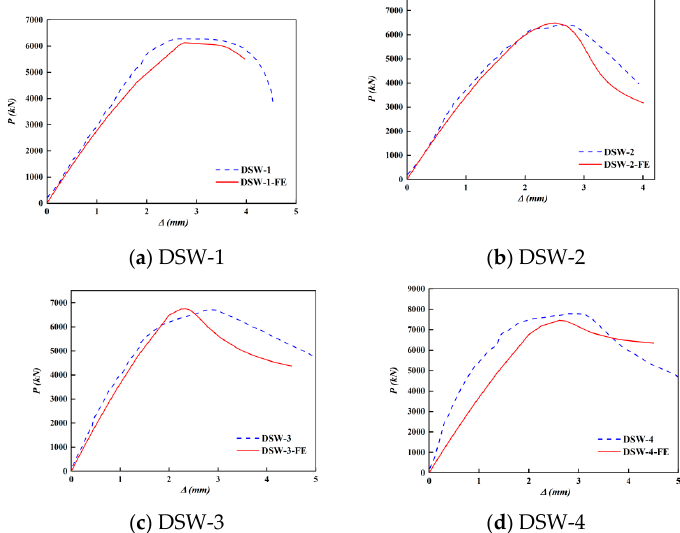
Figure 8. Experimental and numerical in-plane displacement curves (P- Δ curves) of SCS sandwich walls.